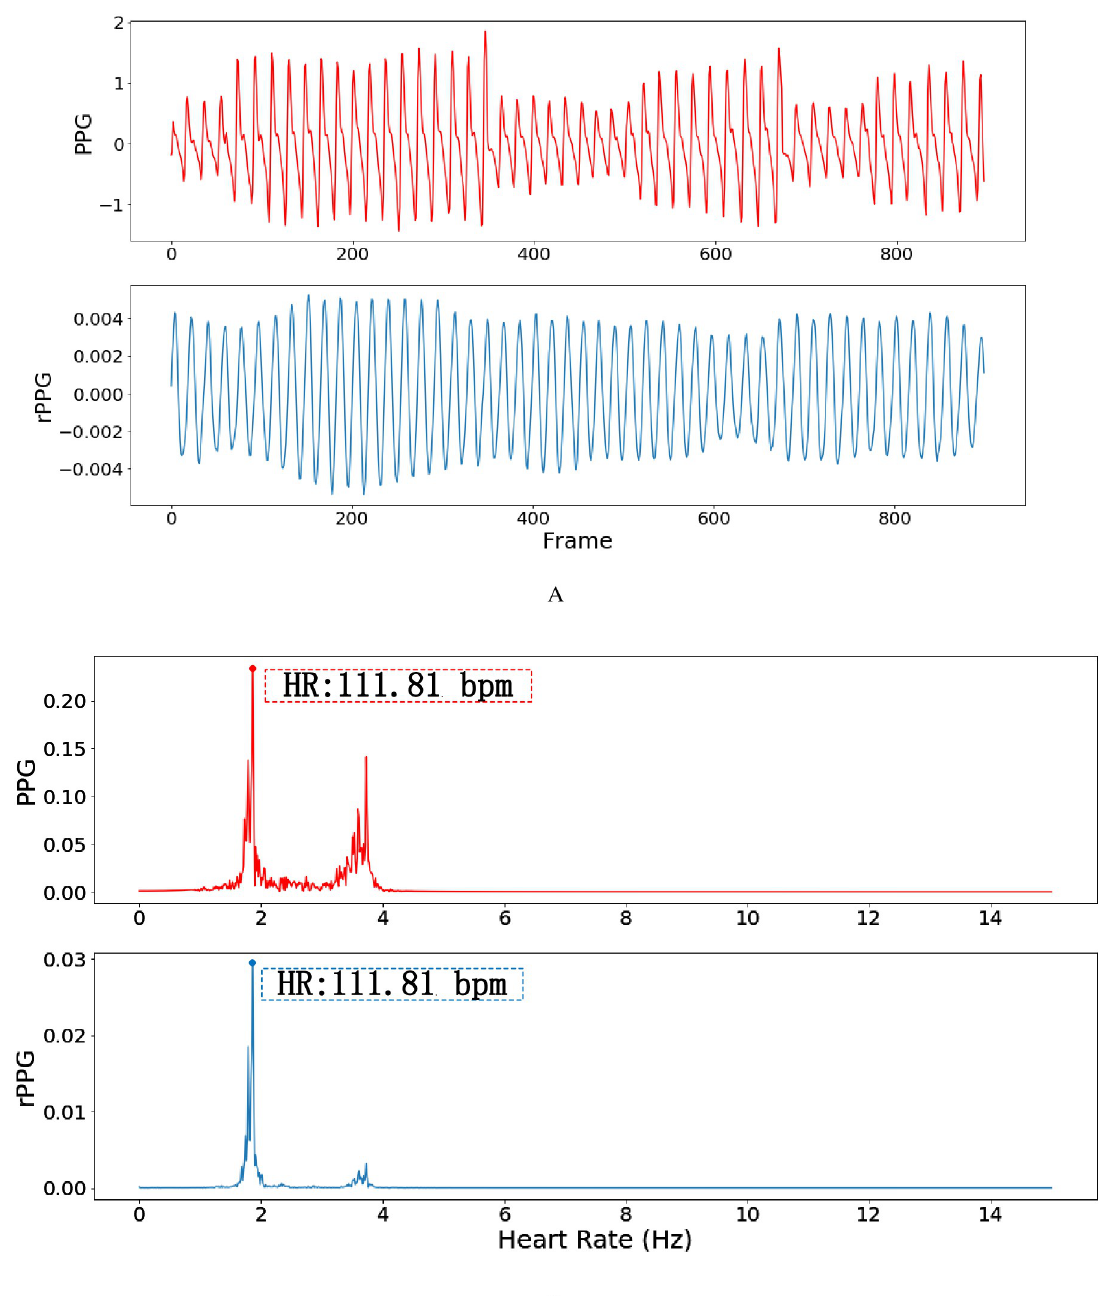
Fig 12. Comparison of LA-SSA result with reference PPG signal. A: Waveform comparison. B: Spectrum comparison. https://doi.org/10.1371/journal.pone.0275544.g012 (ST, the images recorded by the camera were displayed on screen and shown to the subjects. A moving rectangle of the size of the face was added to the image, and the subjects were asked to keep their face inside), fast translation (FT, has the same setup as slow translation, except twice the speed of the moving target), small rotation (SR, different targets that were placed at 35 cm around the camera. The subjects were told to look at these targets in a predefined sequence.